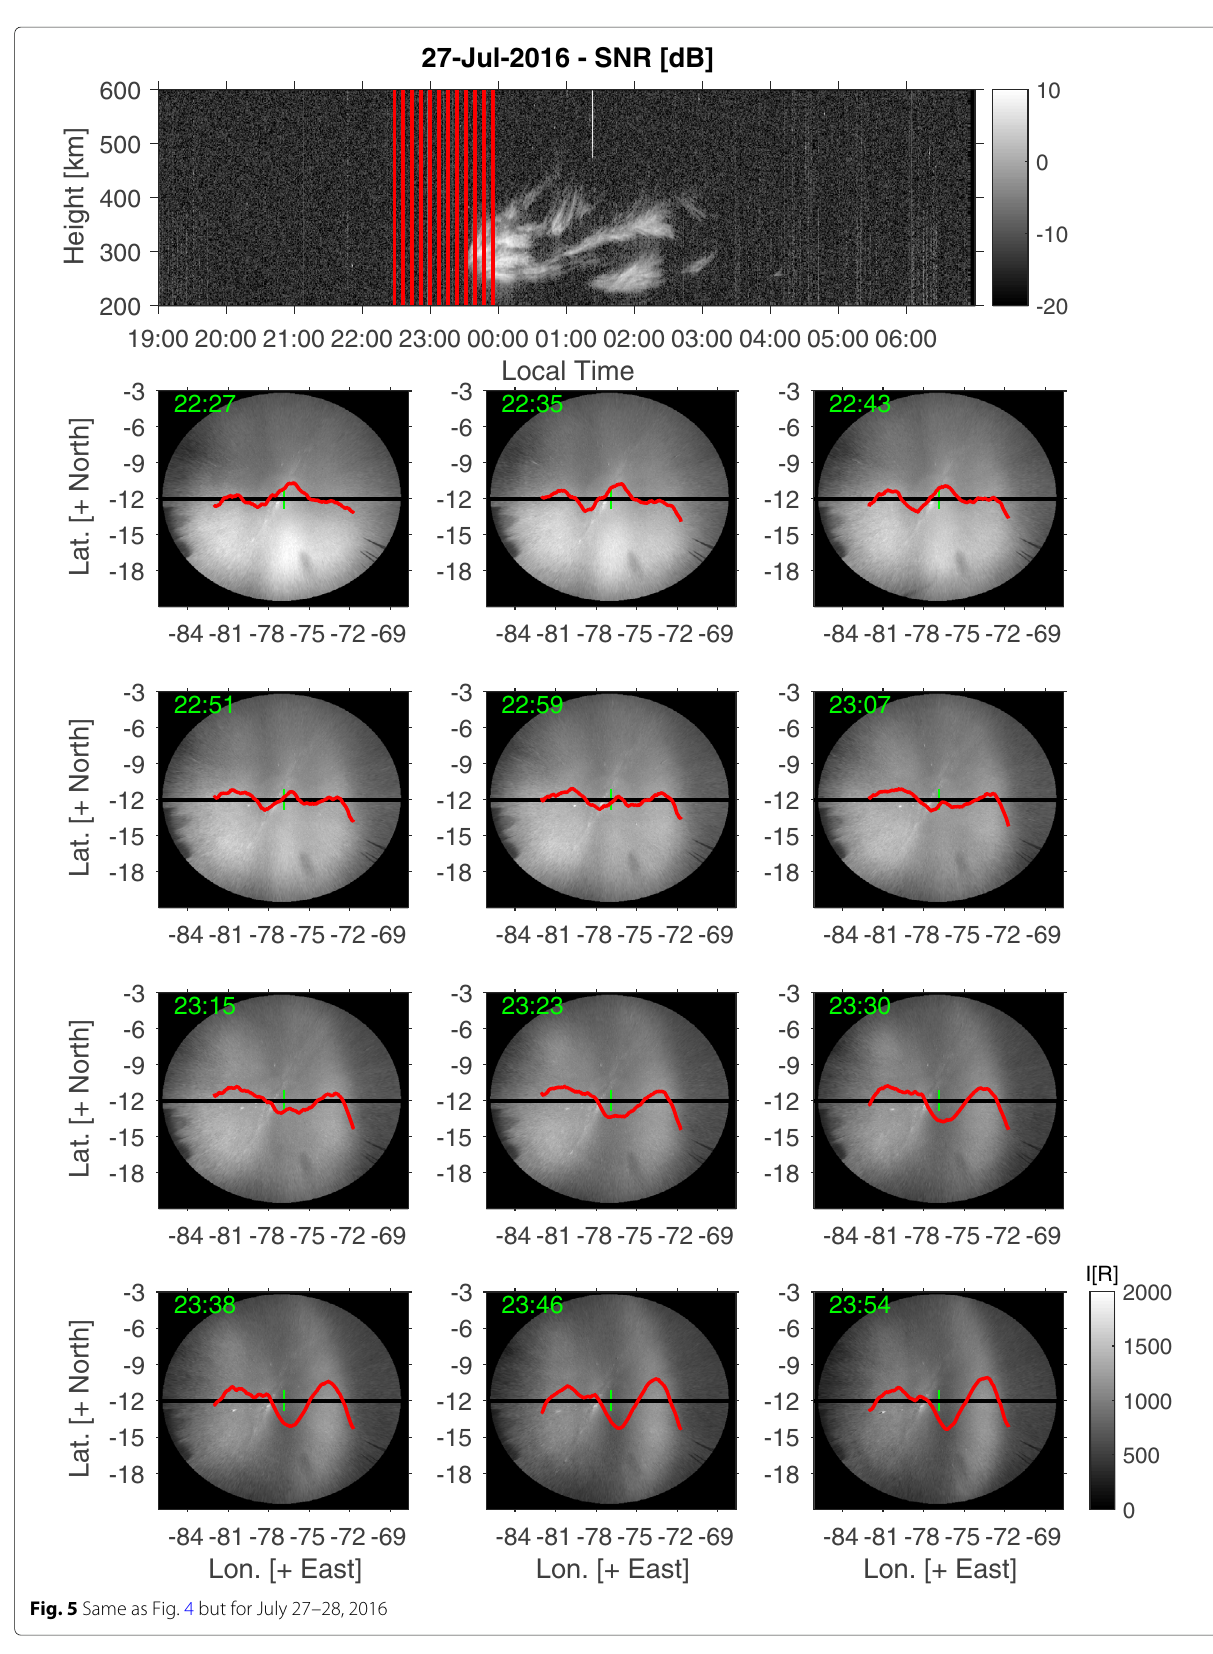
Fig. 5 Same as Fig. 4 but for July 27–28,